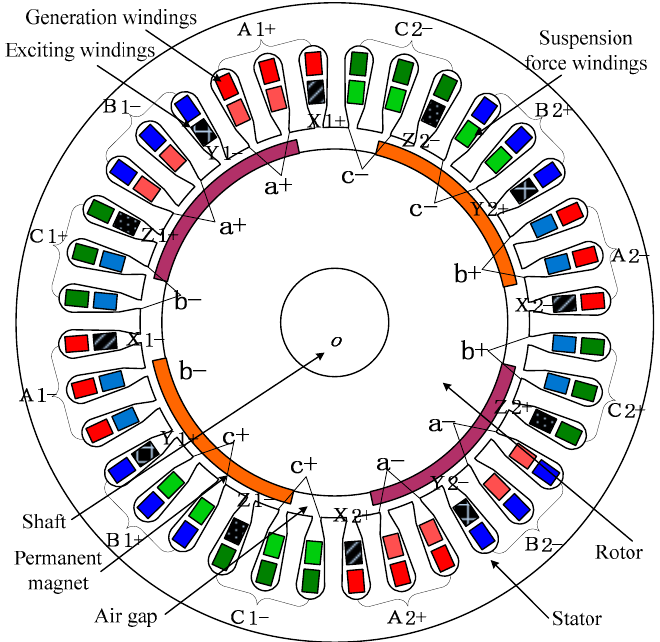
Figure 1. The structure and windings distributions of the hybrid excitation bearingless permanent magnet generator (HEBPMG).